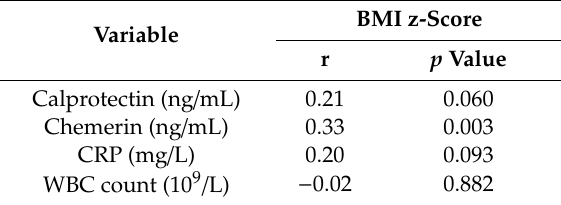
r, Pearson’s correlation coe ffi